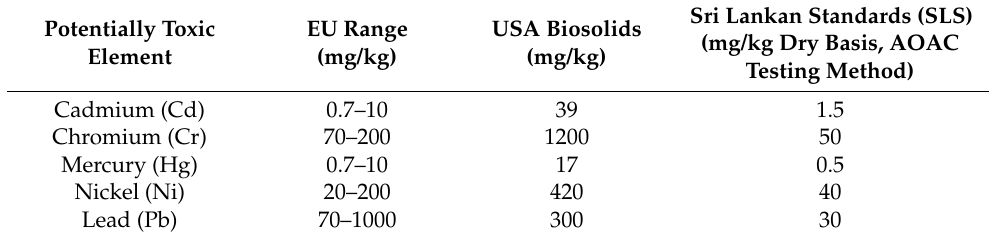
Table 2. The maximum limits for potentially toxic elements promulgated by different agencies [63,65].